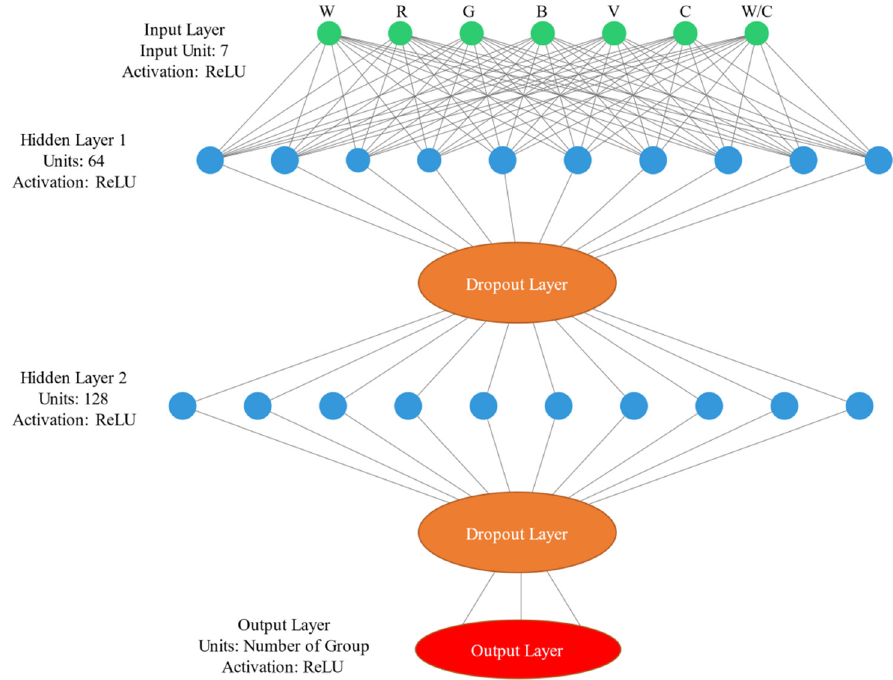
Table 2. Hyperparameters for the feed-forward artificial neural network .